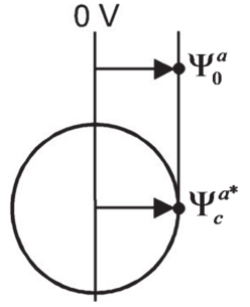
Fig. 4: The (horizontally oriented) external field (component) a = aE induces the potentials Ψ and Ψ ca * in the absence E 0 a a (subscript 0) and the presence (subscript c) of an ellipsoidal (cellular) object at the site of the pole of its semiaxis a . Ψ ca * is highest for a vacuum object with a polarizability comparable to that of a membrane covered cell at low frequency. For example, a vacuum sphere attracts the equipotential plane that is located at the "influential radius" a inf distance of 3 a / 2 from the symmetry plane, which can be assumed to be at 0 V. While the E is determined by the influential radius, maximum of Ψ ca * = a inf a i.e. the geometry of the object, its actual value is determined by the effective electric properties of object and suspension